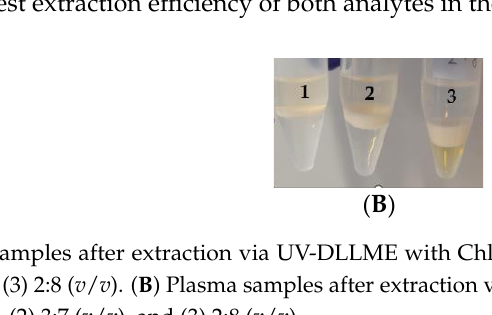
of 4:6 ( v / v ) produced droplets with proper volume and a smaller layer of proteins at the phase boundary (Figure 1B) compared to the Chl:MeOH mixture at the same ratio (4:6, v / v ) (Figure 1A). Overall, the results indicated that the mixture of Chl:EtOH at a ratio of 4:6 ( v / v ) provided the best extraction efficiency of both analytes in the plasma samples.